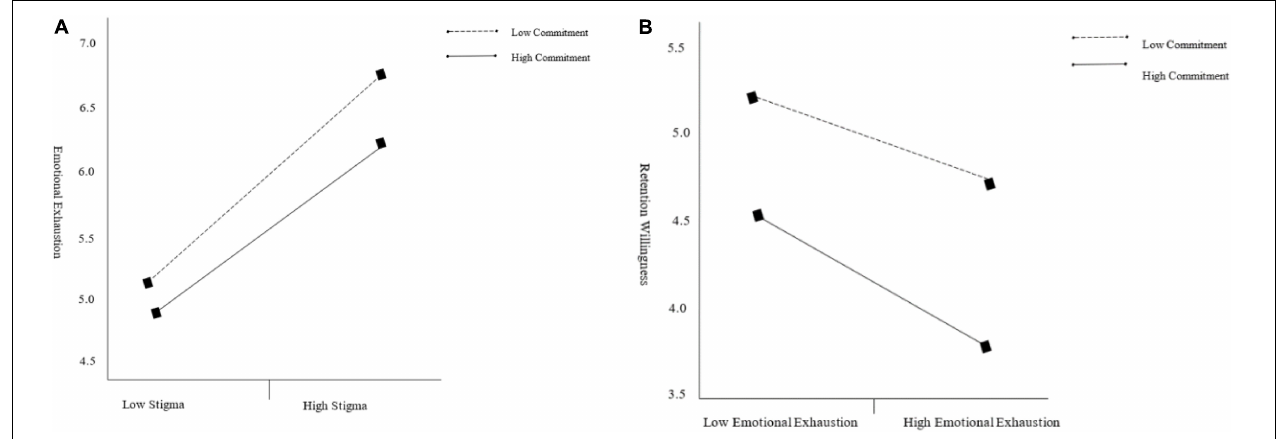
FIGURE 4 | Moderating effects of professional commitment. (A) Moderating effects of professional commitment on the relationship between perceived occupational stigma and emotional exhaustion. (B) Moderating effects of professional commitment on the relationship between emotional exhaustion and retention willingness.